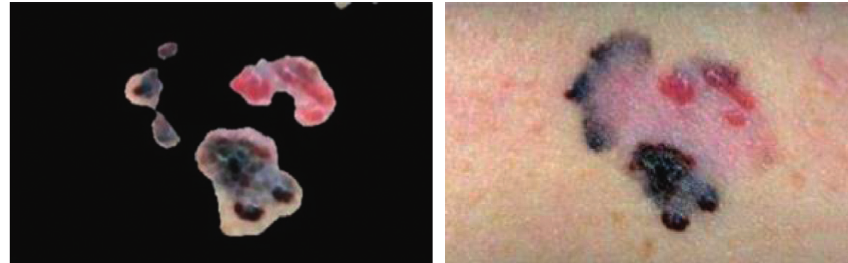
Figure 5: Segmentation of preprocessed skin image.